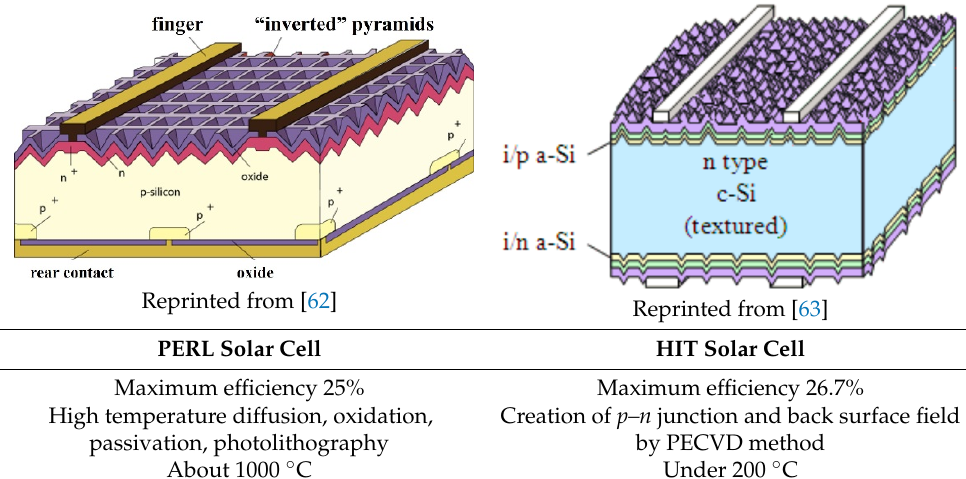
Reprinted from [62]